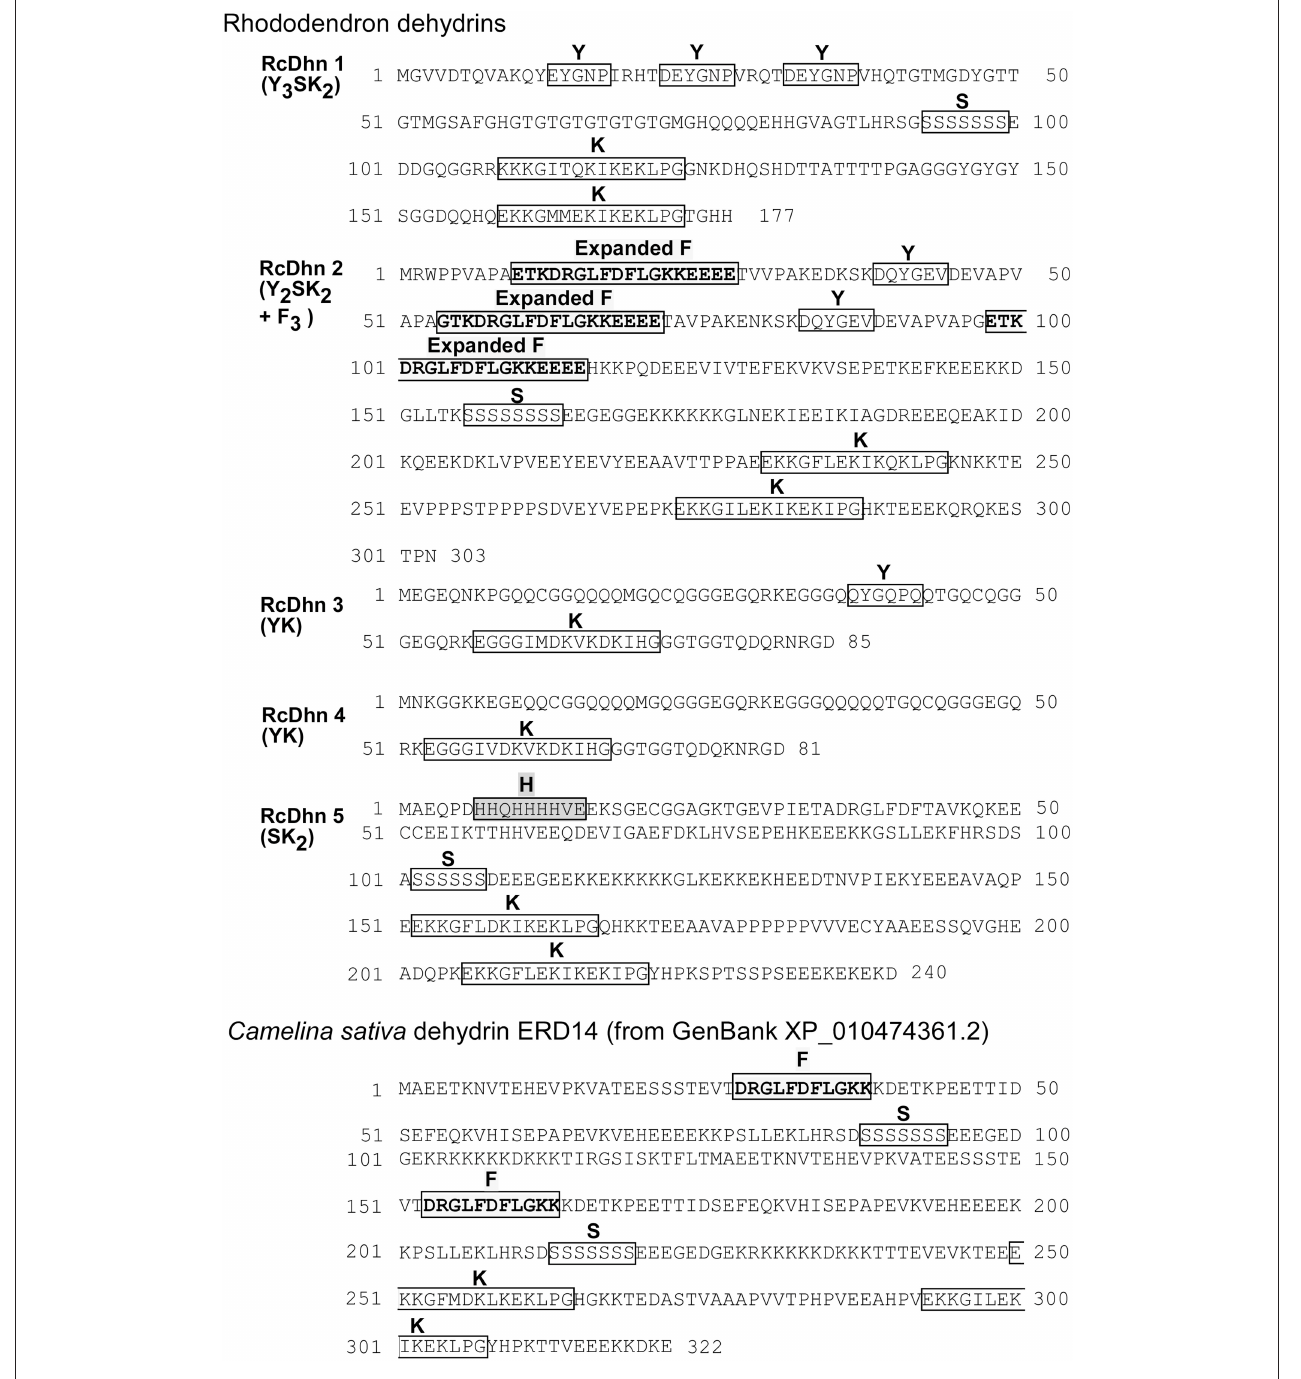
FIGURE 3 | Deduced amino acid sequences for Rhododendron dehydrins RcDhn 1-5 and C. sativa dehydrin ERD14. Amino-acid residues are designated in single-letter code. The Y-, S-, and K-segments are boxed. The defined expanded F-segments in RcDhn 2 are boxed and in boldface and yellow; the histidine-rich (H) segment are boxed and in pink. C. sativa dehydrin ERD14 was identified by our BlastP analysis hit against the NCBI protein